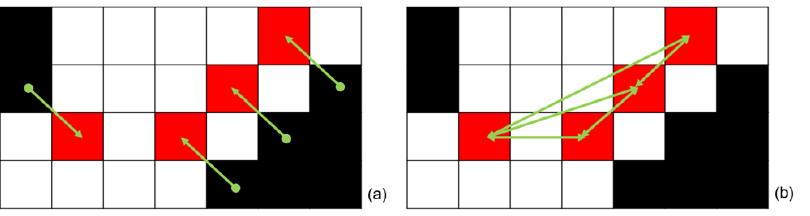
Figure 12. Example of node creation and connection in a diagonal space. ( a ) Example where a node is created by detecting a diagonal space as a corner. ( b ) Example where more connections are created due to the nodes created in the diagonal space.